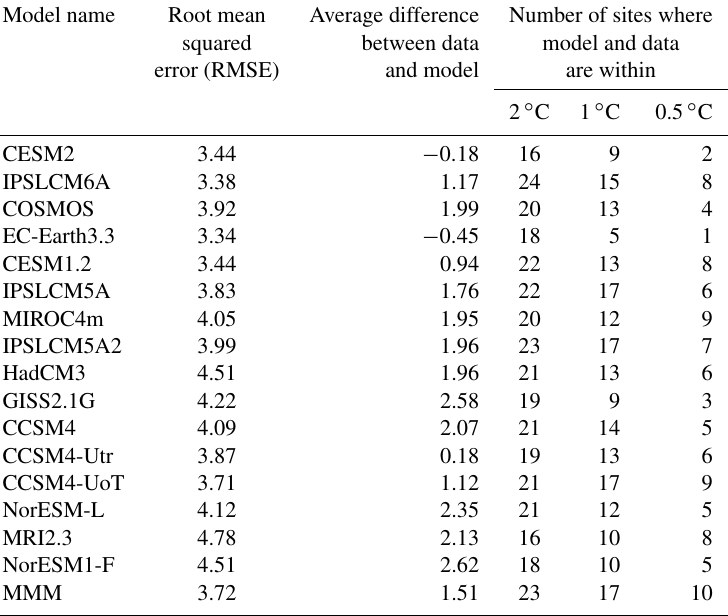
Table 3. Statistical relationships between the proxy data (cid:49) SST and the model (cid:49) SST at each of the individual grid points. The average difference is calculated as (cid:54) | (SSTA(model) − SSTA(data) | /n , where n is the number of sites. Model